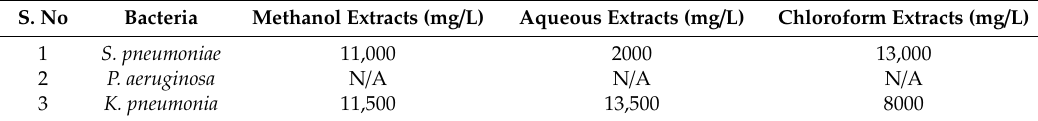
Table 7. Minimum inhibitory concentration (MIC) of Recipe 2 against di ff erent bacterial strains. S. No Bacteria Methanol Extracts (mg / L) Aqueous Extracts (mg / L) Chloroform Extracts (mg / L) 1 S. pneumoniae 11,000 2000 13,000 2 P. aeruginosa N / A N / A N / A 3 K. pneumonia 11,500 13,500